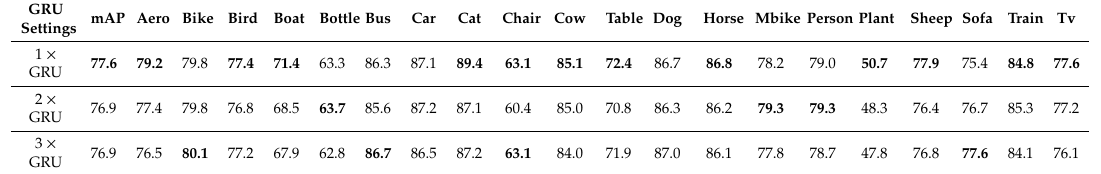
Table 10. Comparison of di ff erent GRU settings utilized in the attention-based global context sub-module. The experiments are conducted on PASCAL VOC 2007. (K × GRU) denotes that there are K stacked GRU units. The bold characters represent the best result for each column.